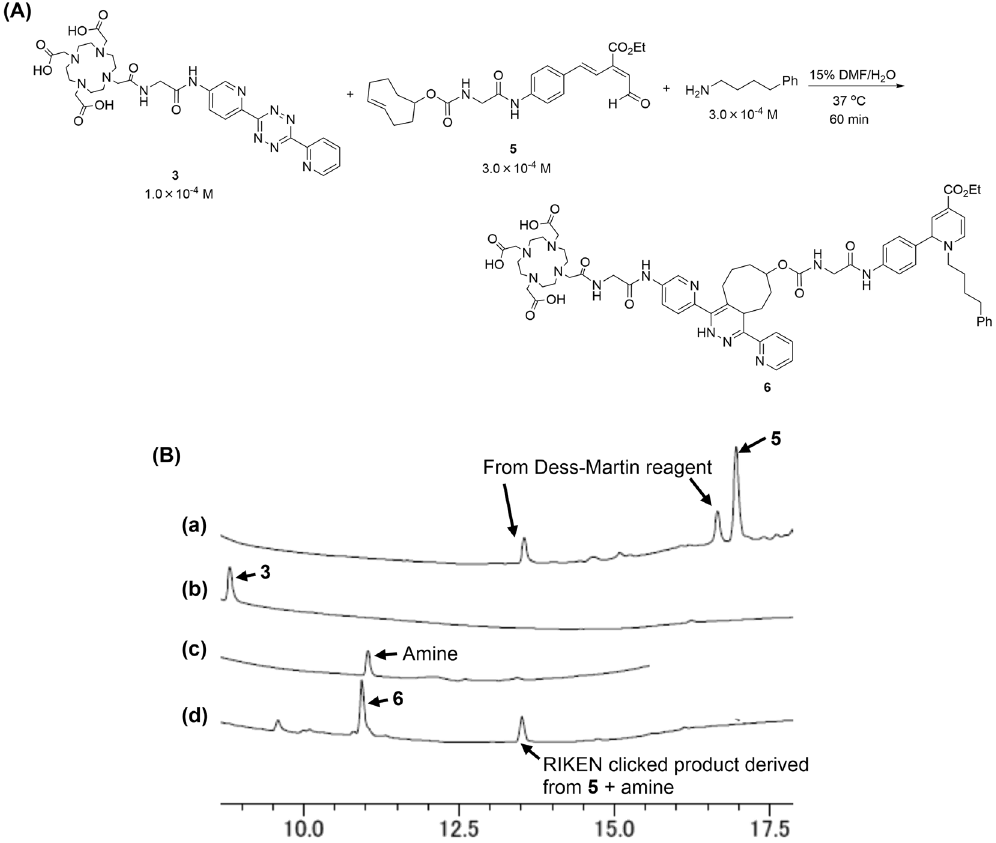
Figure 2. One-pot three-component double-click labeling with 4-phenyl-1-butylamine as a model primary amine. ( A ) Scheme and conditions. ( B ) Reverse phase HPLC analysis. Charts indicate: (a) TCO-substituted aldehyde 5 , (b) DOTA-substituted tetrazine 3 , (c) 4-phenyl-1-butylamine, and (d) reaction mixture. In chart (a), a peak at 16.8 min corresponded to aldehyde 5 and other two peaks at 13.6 and 16.4 min are derived from Dess-Martin reagent during oxidation of the alcohol precursor synthesizing to TCO-aldehyde 5 . In chart (d), two peaks at 10.9 and 13.5 min corresponded to three-component coupling product 6 (m/z 1182.8 calcd for C 60 H 71 N 13 O 13 [M + H] + ) and RIKEN clicked product derived from three-fold excess 5 and 4-phenyl-1- butylamine (m/z 584.3 calcd for